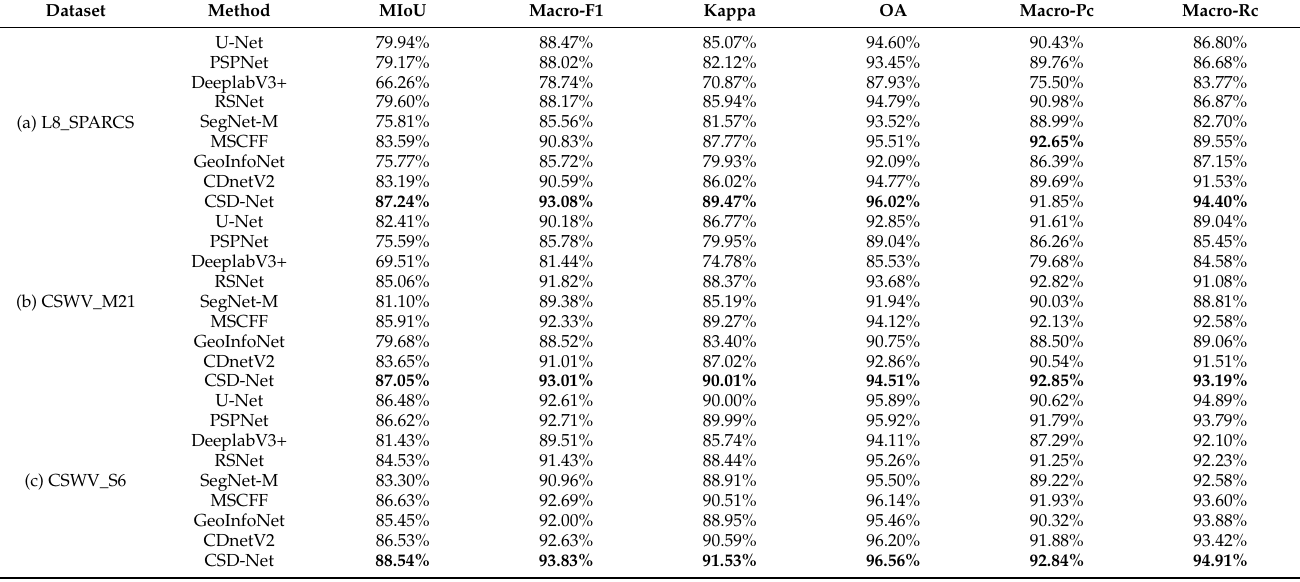
Figure 9. On the L8_SPARCS dataset, the visual comparison of cloud and snow detection results for several deep learning methods. It lists the original images, the detection results of various methods, and the ground truths one by one. The delineated areas with the green boxes were magnified to provide a more detailed visual comparison. Table 4. The cloud and snow detection accuracy comparisons on the various